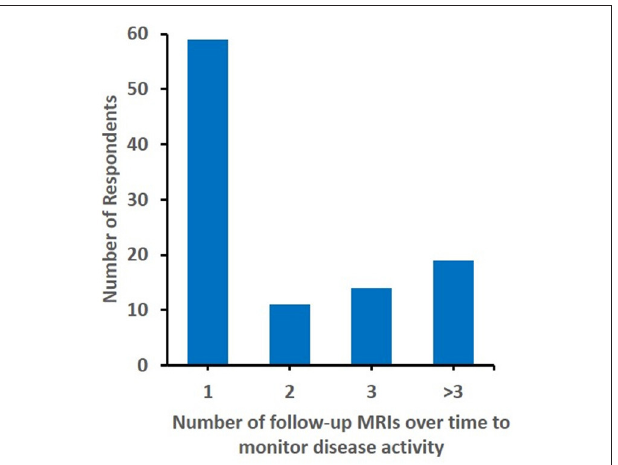
FIGURE 2 | Number of follow up MRIs considered. The number of follow-up MRIs to montior diseadse activity considered by ( N = 103) responents is